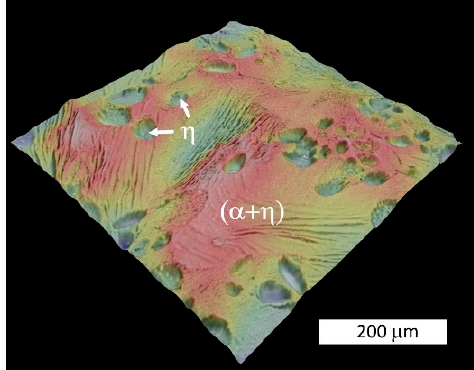
Figure 14. 3D SEM topography of the sample surface after polarization up to a potential of +450 mV vs. E corr . The image based on “shape from shading” technology shows the selective dissolution of the η -phase and a macroscopic exposure of the eutectic structure. Blue indicates the lowest areas, while red represents the highest features.